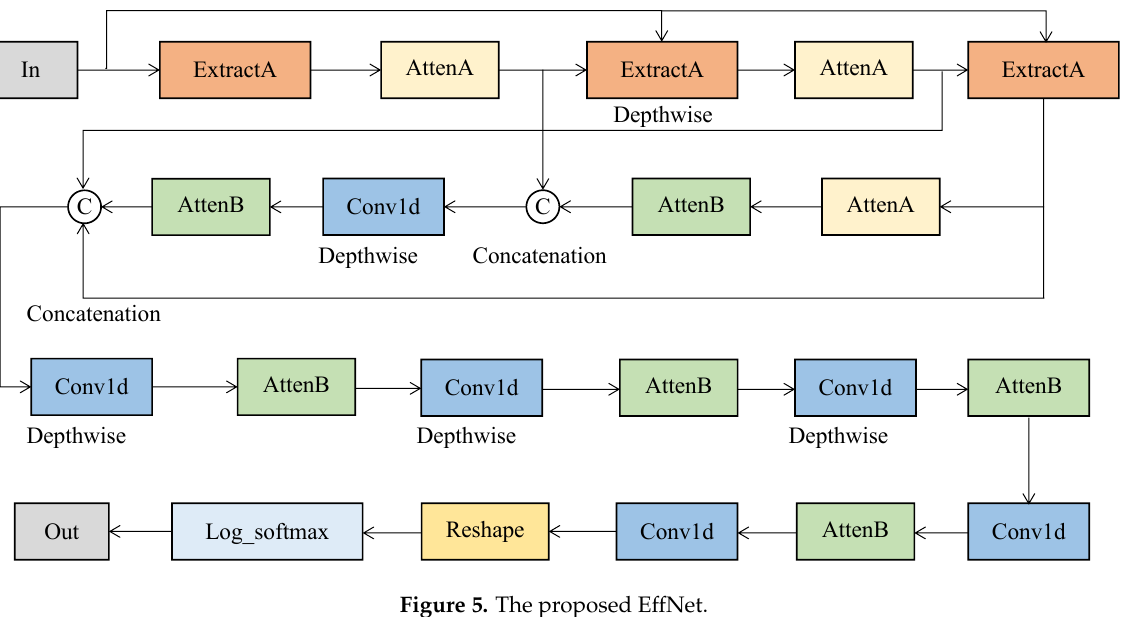
Figure 5. The proposed